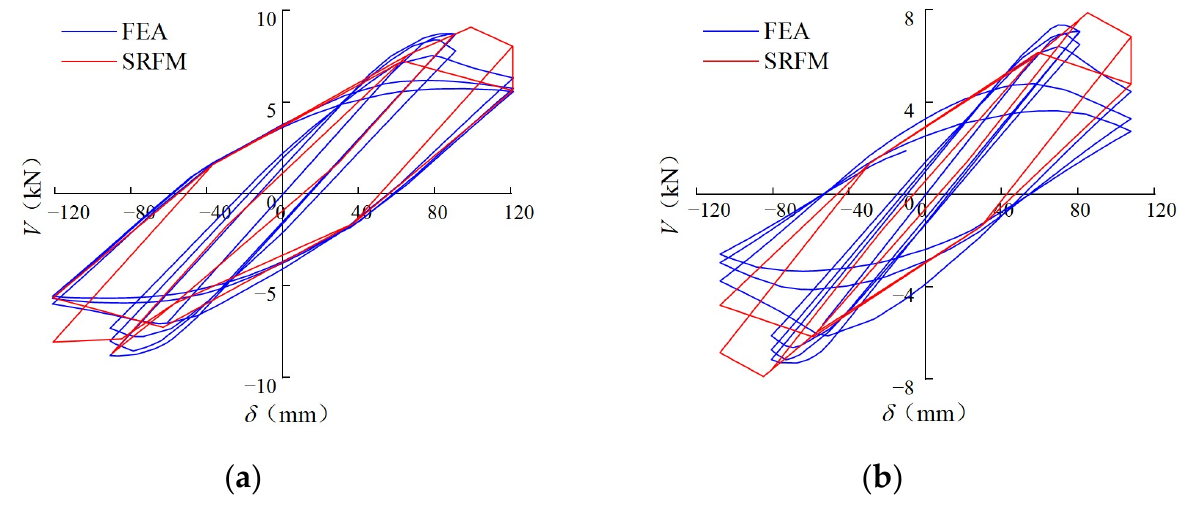
Figure 32. The comparison on the hysteresis curves between FEA model and SRFM for members failed with local and global coupling instability. ( a ) C4-BC-L70-70-01. ( b )C4-BC-L70-70-02.